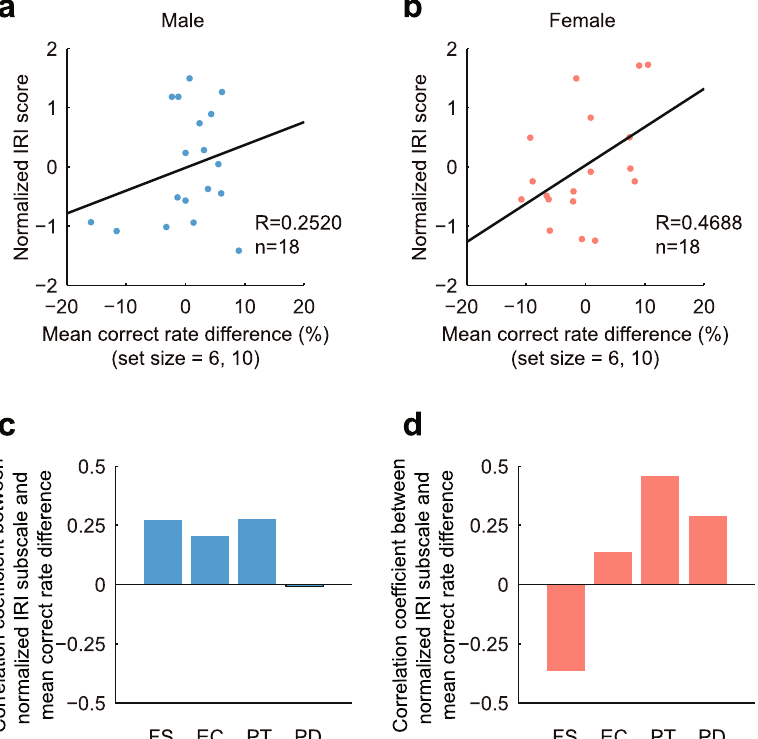
Figure 5. Empathy skill-dependent modulation of working memory in the existing working memory task. (a,b) The correlations between normalized IRI scores and mean correct rate differences for males (a) and females (b) . The correlation was significant for females (R = 0.4688, P = 0.0497), but not for males (R = 0.2520, P = 0.3131). (c,d) The correlations between four IRI subscales and the mean correct rate differences. For